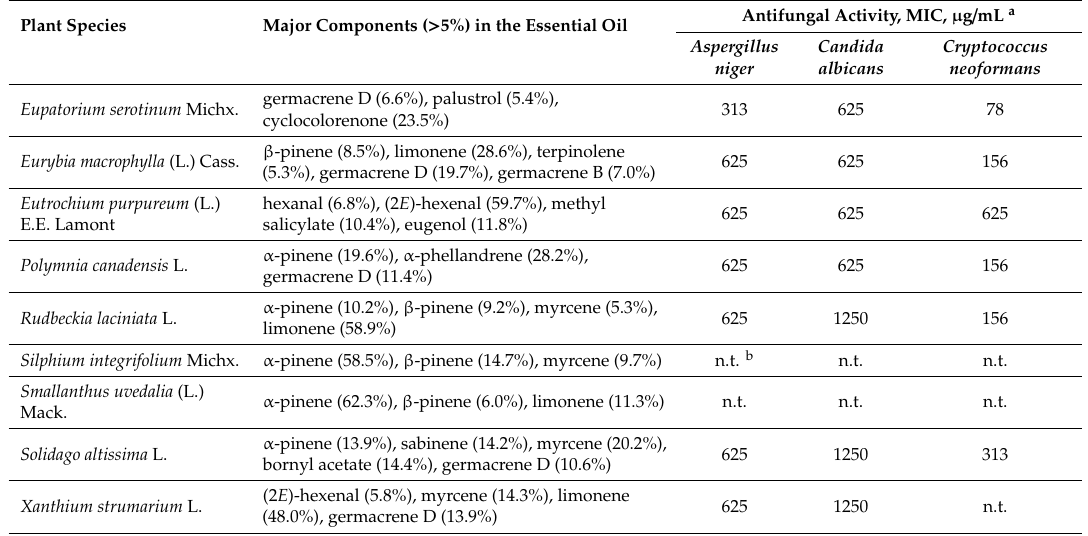
Table 12. Major components and antifungal activities of Asteraceae essential oils. Plant Species